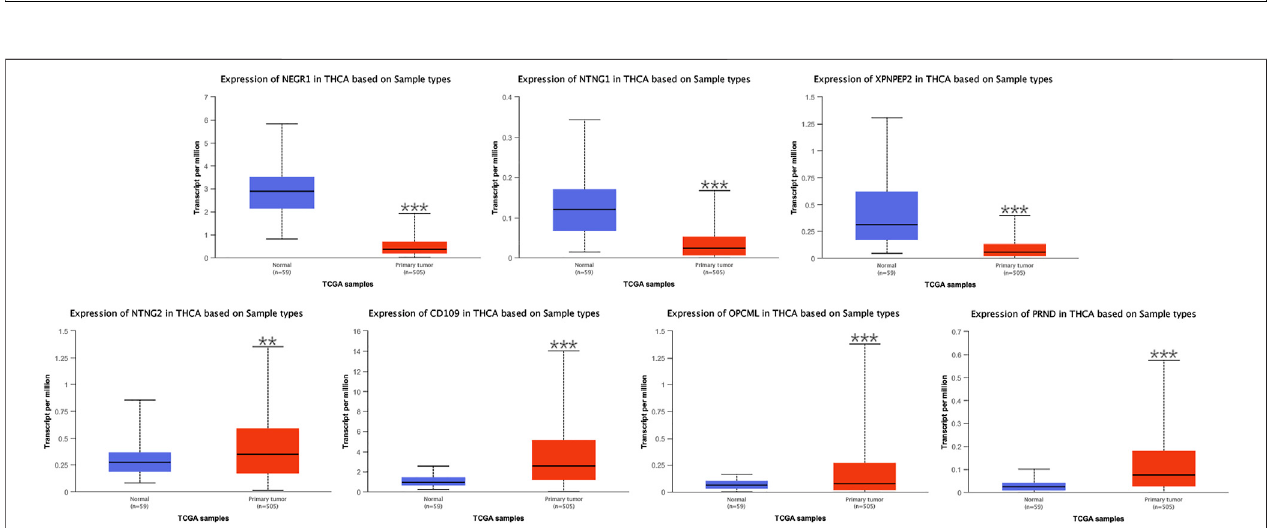
( Figure 6B ). For the other critical genes, results of the survival analysis were not statistically signi fi cant.